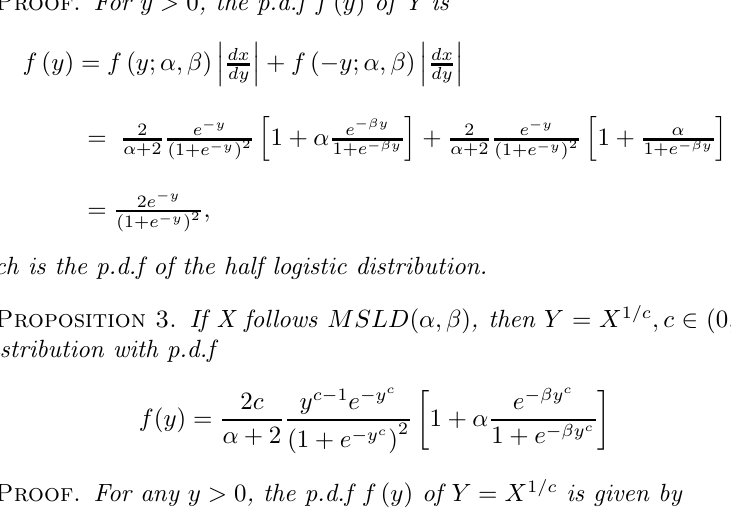
which shows that the p.d.f of Y can be considered as a convex mixture of the p.d.f of the standard logistic and and skew-logistic